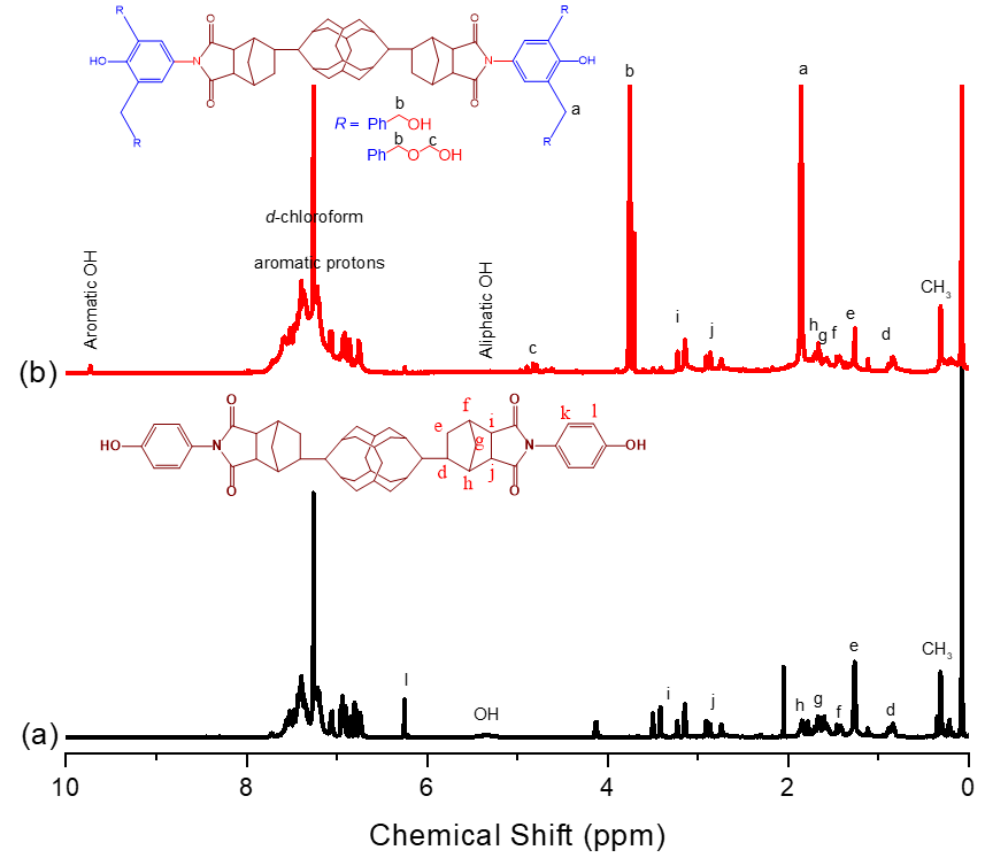
Figure 1. 1 H NMR spectra of ( a ) DDSQ-4OH and ( b ) pure PDDSQ.